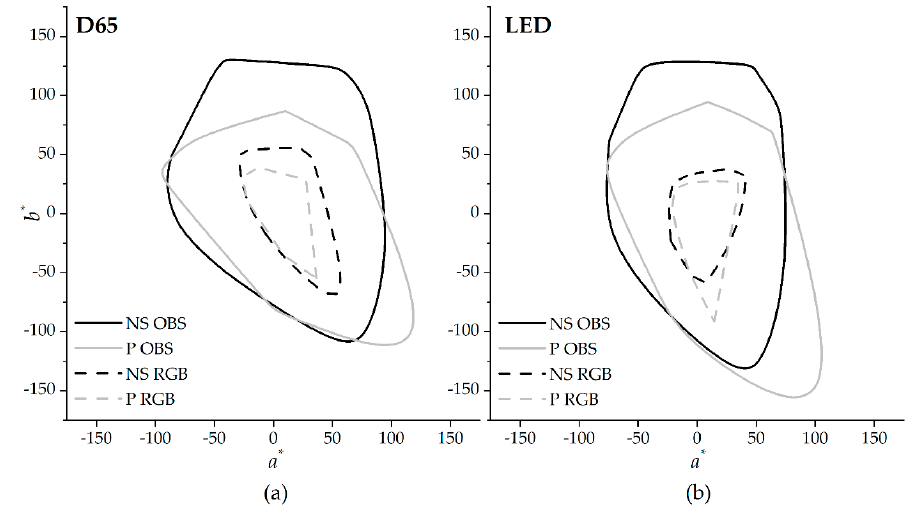
Figure 4 represents the estimated color gamut for natural scenes (black color) and paintings (light grey color), computed for the standard observer (OBS, full lines) and the digital camera (RGB, dashed lines) assuming the CIE D65 (panel (a)) and LED (panel (b)) illuminants. Sensors 2020 , 20 , x FOR PEER REVIEW